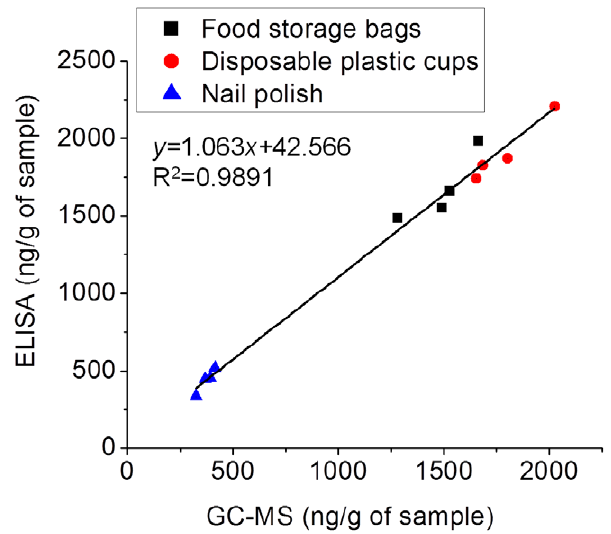
Figure 6. Correlation of ELISA and GC-MS analysis of certain household items. Each point represents the mean of three replicates of one sample.